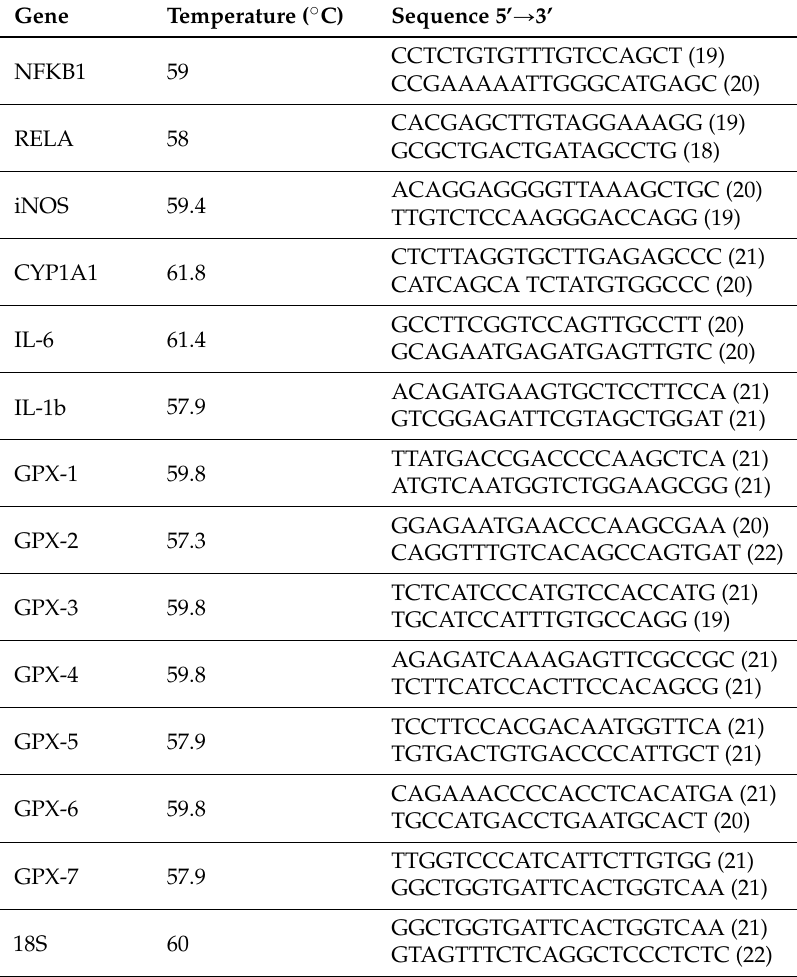
Table 5. Parameters for RT-qPCR